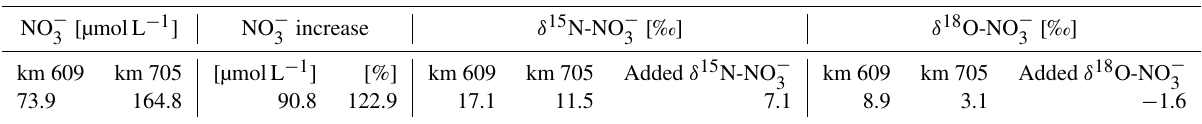
Table 4. Added nitrate values. The initial values and the changes in the nitrate concentration (µmolL − 1 ) and the associated stable isotopes ( δ values in ‰) between Elbe stream km 609 and km 705 are